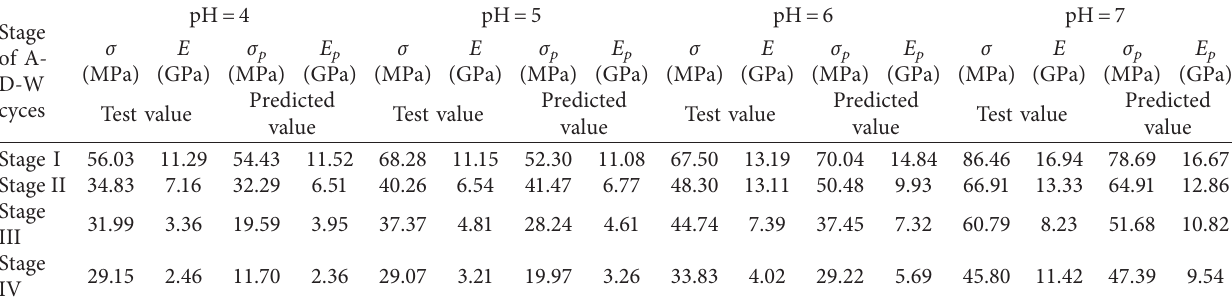
Table 7: Comparison of calculated value and test value of damage model.